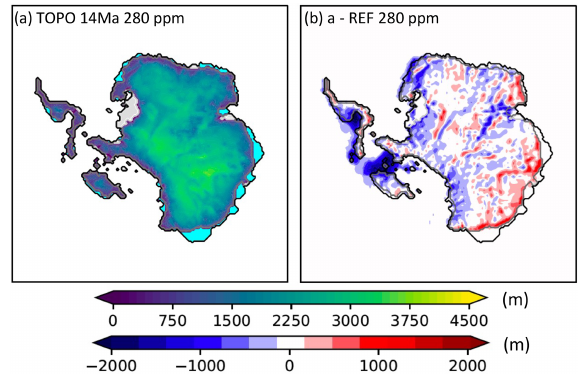
Figure 4. (a) Simulated equilibrated grounded ice thickness from experiment TOPO 14Ma with 280ppm CO 2 forcing. Cyan areas indicate ice shelf extent and grey areas ice-free land. (b) Difference in ice thickness between TOPO 14Ma and REF with 280ppm CO 2 forcing (grounding line and continental edge as in a